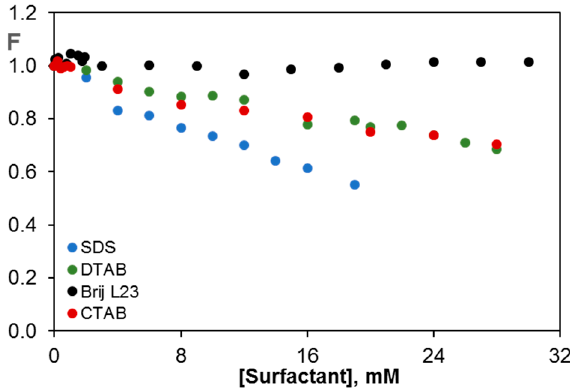
Figure 1. Change in the fluorescence of vitamin B 2 (F) with increasing concentration of the different surfactants.